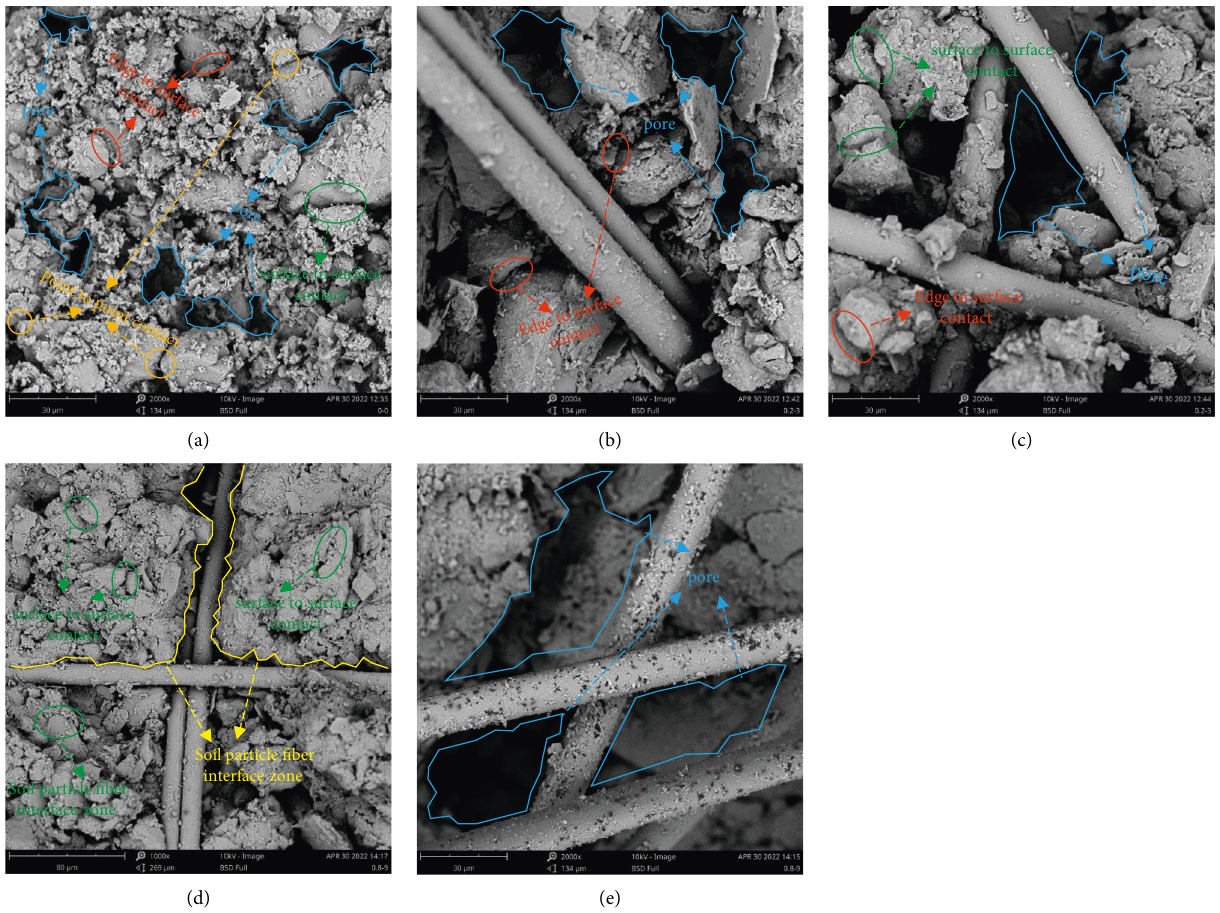
Figure 11: Qualitative analysis with glass fiber incorporation (2000 times magnification) (a) 0% plain soli (b) 0.2% incorporation soli (c)